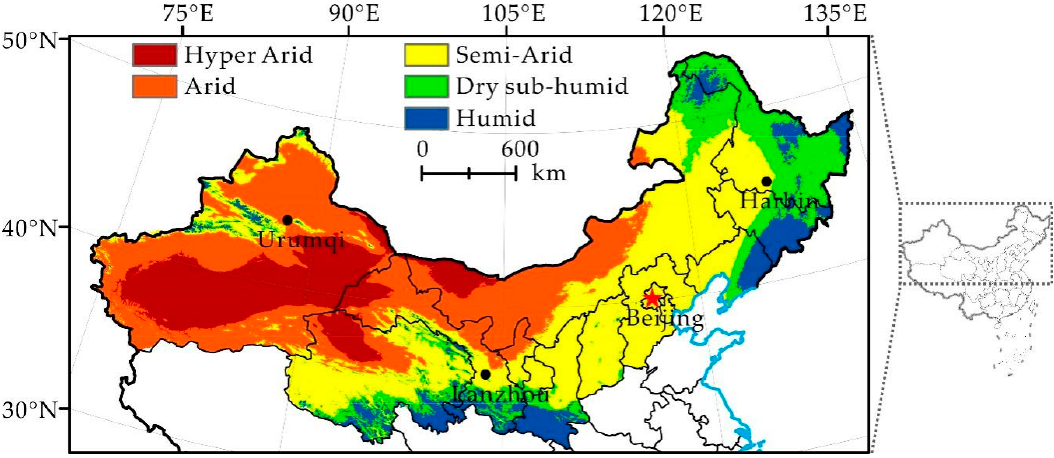
Figure 1. Location of the Study Areas [32].